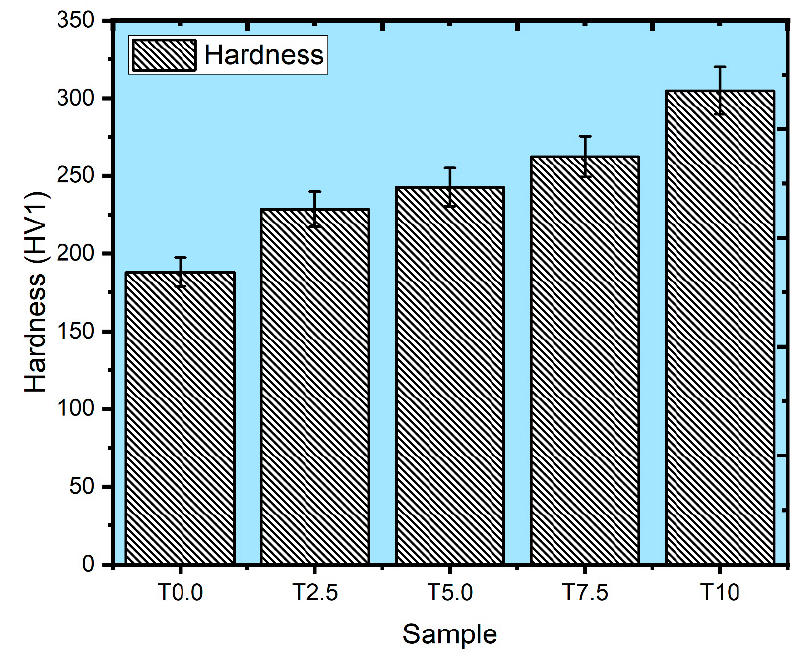
Figure 7. Vickers hardness of sintered samples.